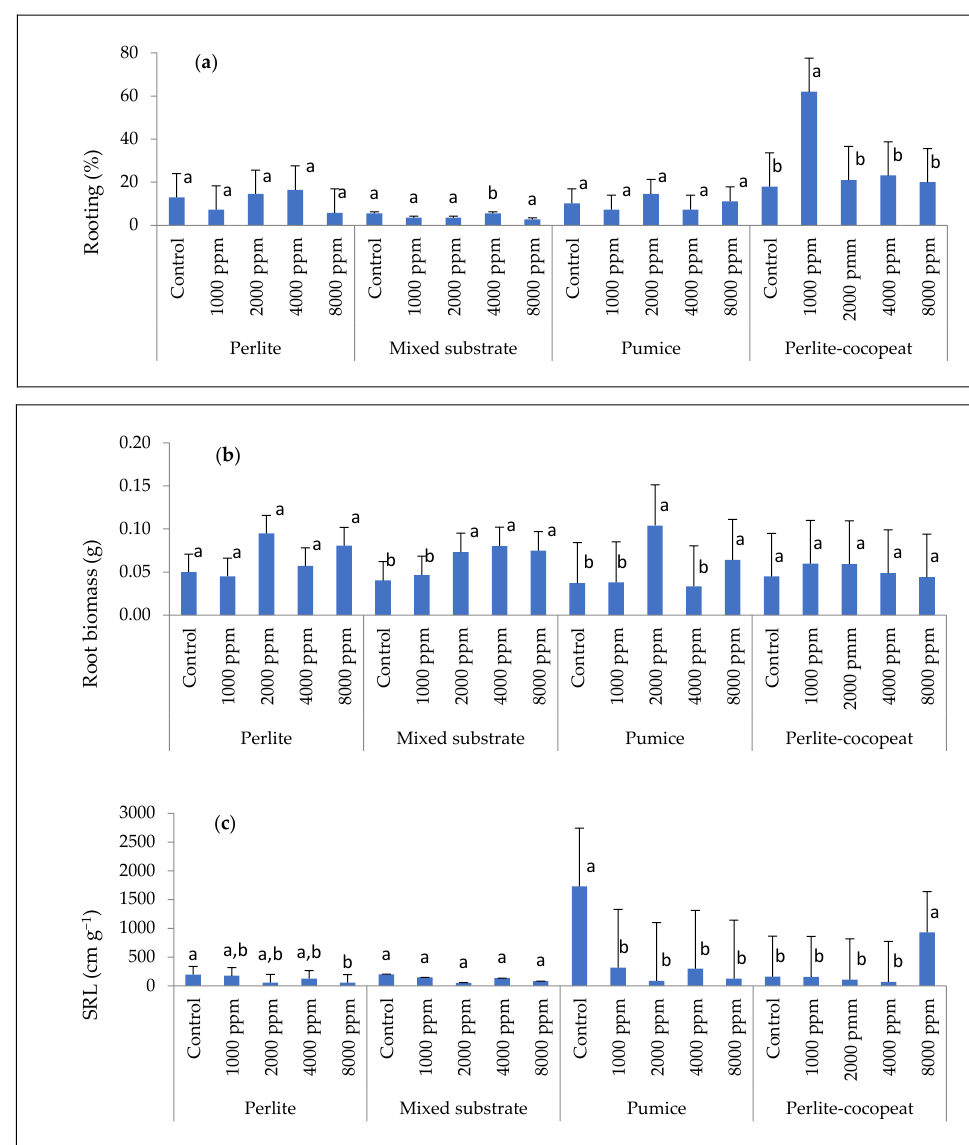
Figure 3. Mean values of rooting performance in rooted cuttings within seasons and with five indole butyric acid (IBA) pretreatments: ( a ) % of rooting, ( b ) root biomass, and ( c ) SRL. Mean values with the same letter do not differ at 0.05 level according to LSD test. Sample data = 540 cuttings in each season. Treatments in which all cuttings dried are not represented in the figure. Error bars: LSD intervals. * Rooting percentage was zero.